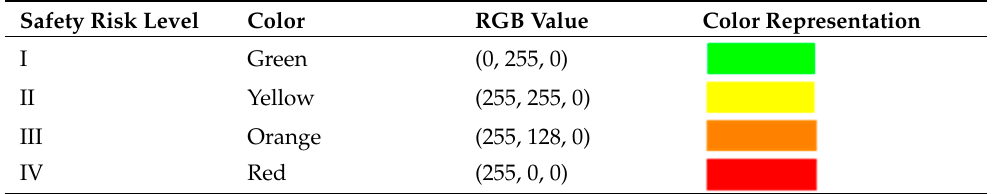
Table 4. Color representations for different safety risk levels.